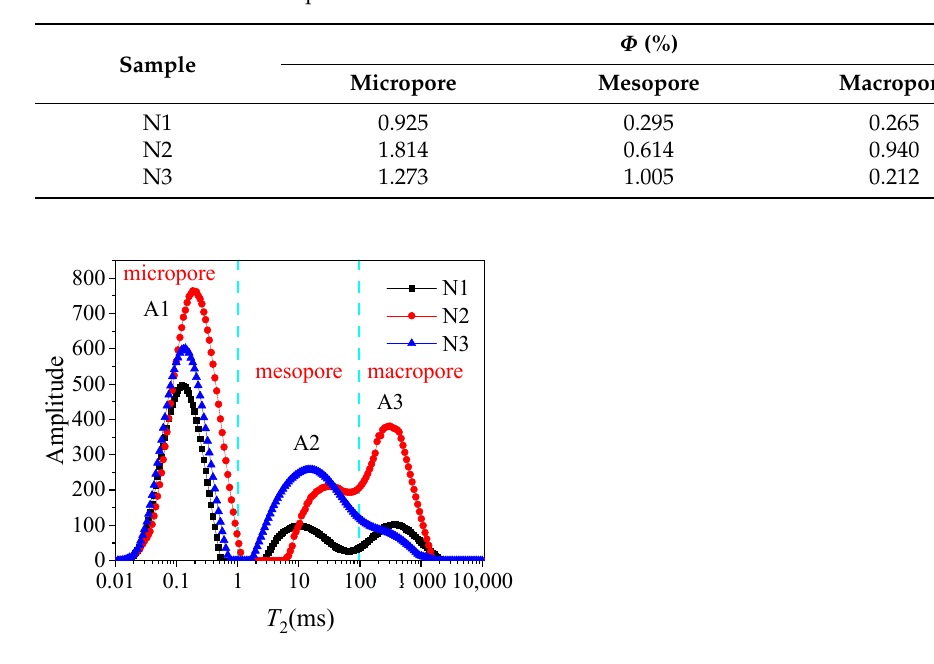
Figure 2. T 2 distribution of water-saturated coal samples.